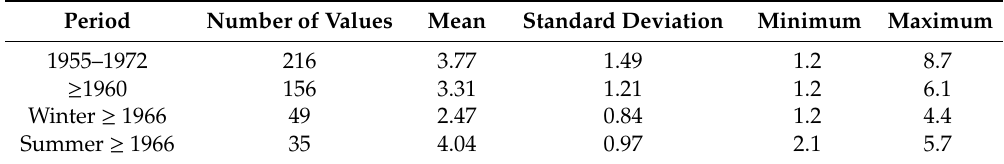
Table 1. Summary of statistics of the ozone concentration. The units are in parts per hundred million